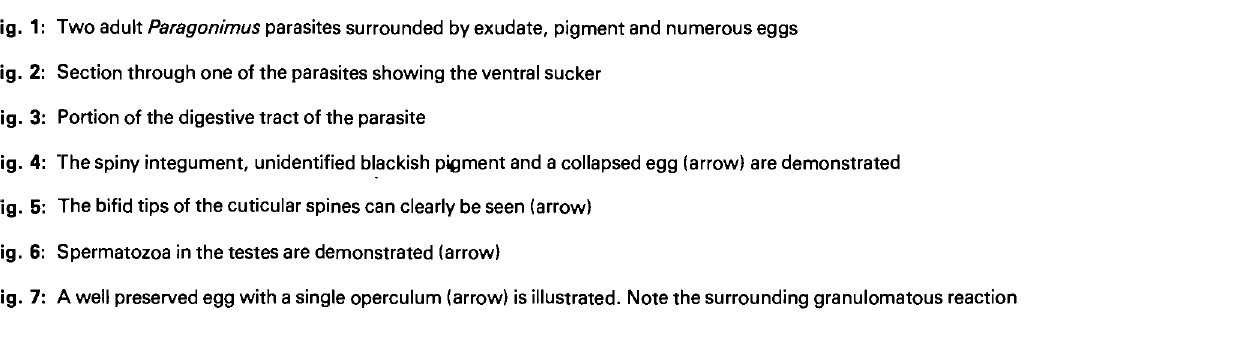
Fig. 1: Two adult Paragonimus parasites surrounded by exudate, pigment and numerous eggs Fig. 2: Section through one of the parasites showing the ventral sucker Fig. 3: Portion of the digestive tract of the parasite Fig. 4: The spiny integument, unidentified blackish pigment and a collapsed egg (arrow) are demonstrated Fig. 5: The bifid tips of the cuticular spines can clearly be seen (arrow) Fig. 6: Spermatozoa in the testes are demonstrated (arrow) Fig. 7: A well preserved egg with a single operculum (arrow) is illustrated. Note the surrounding granulomatous